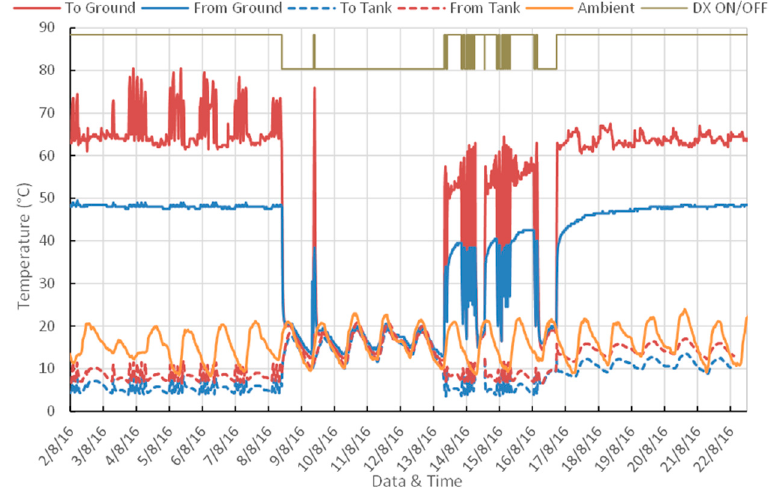
Figure 4. Temperatures of DX ground loop, DX tank loop and the ambient air between August 1 and August 22, 2016. The heat pump On/Off status is also shown by the curve on the top.